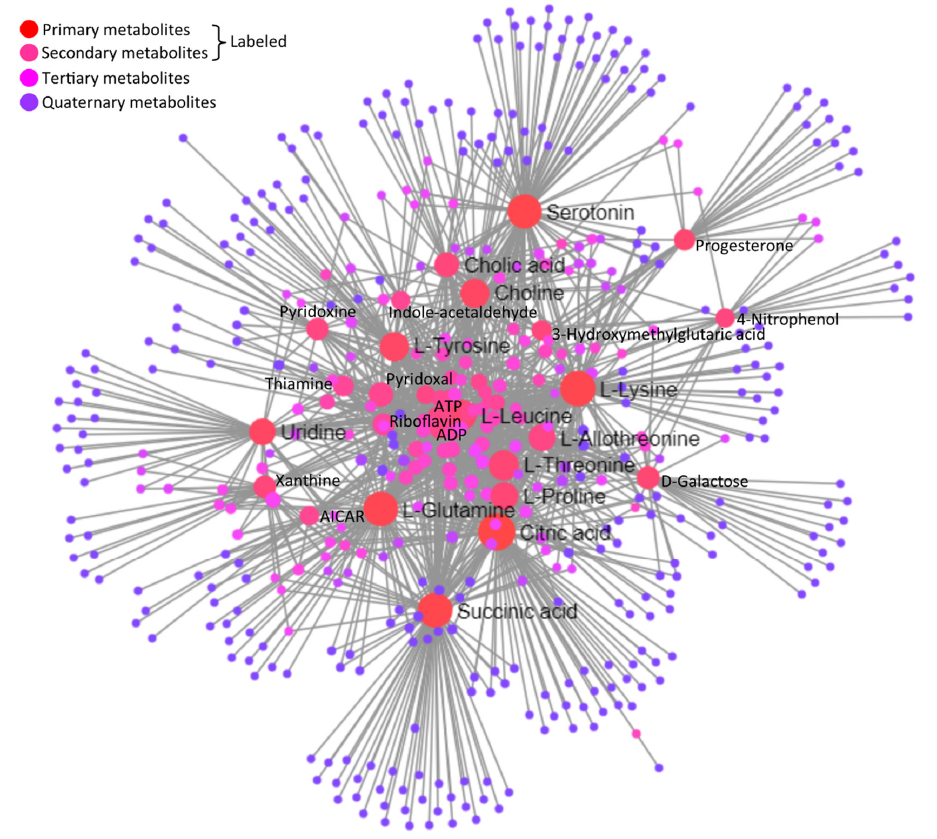
Table 5. The statistical details of the whole interaction network are given in Supplementary Table S6.